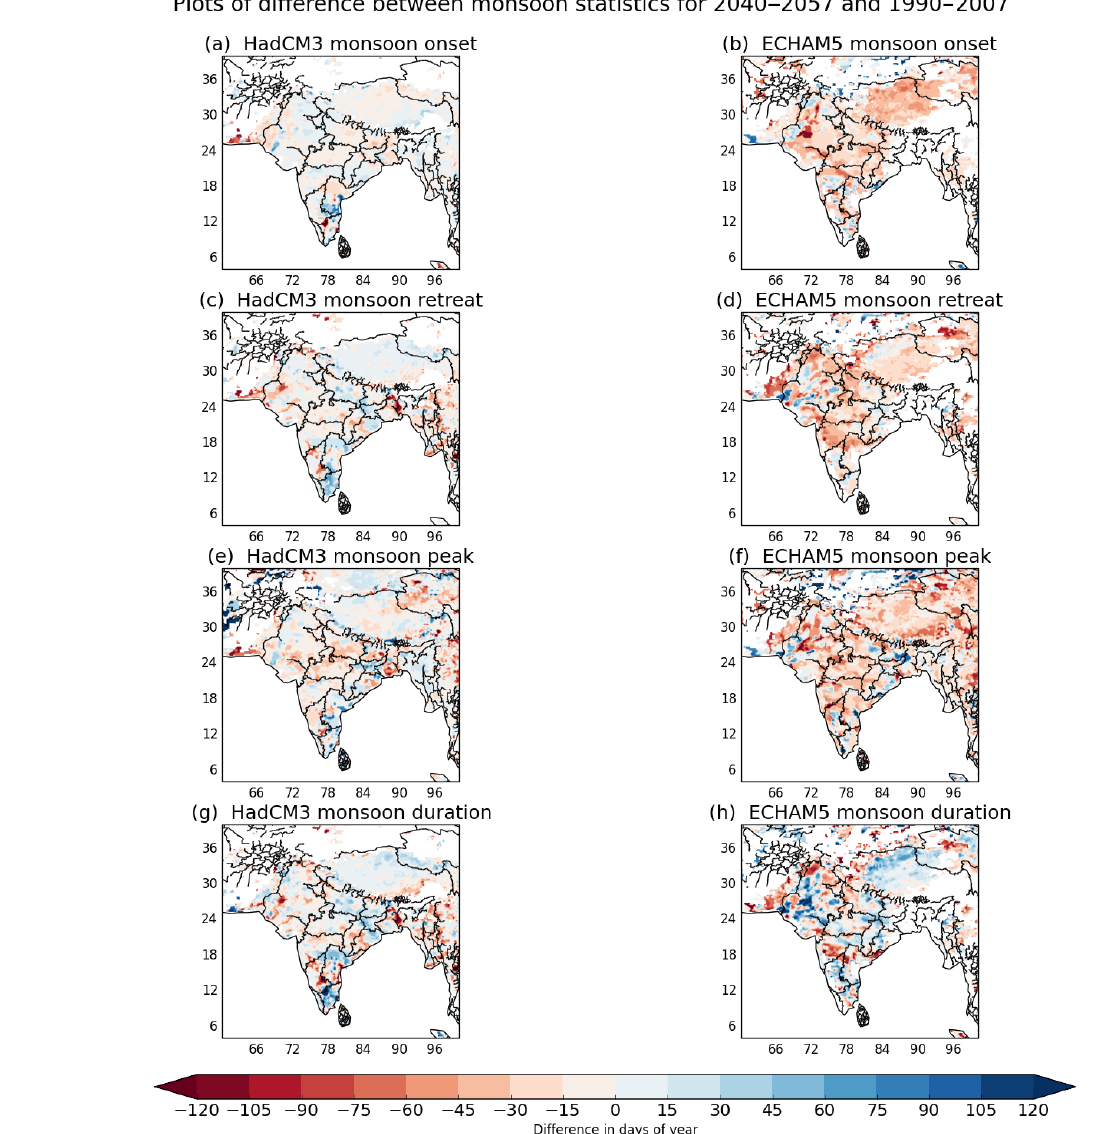
Figure 9. The difference between the monsoon statistics for the 2040–2057 future period and the present day 1990–2007 for HadCM3 (a, c, e, g) and ECHAM5 (b, d, f, h)